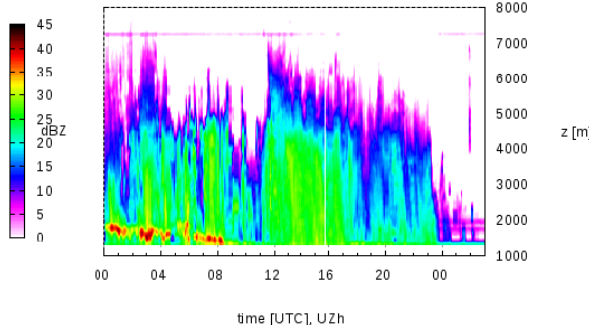
Figure 6. Time–height plot of UZ h based on the birdbath scan which is available every 5min. Data are from 5 until 6 January 2013 in the morning, radar MHP.